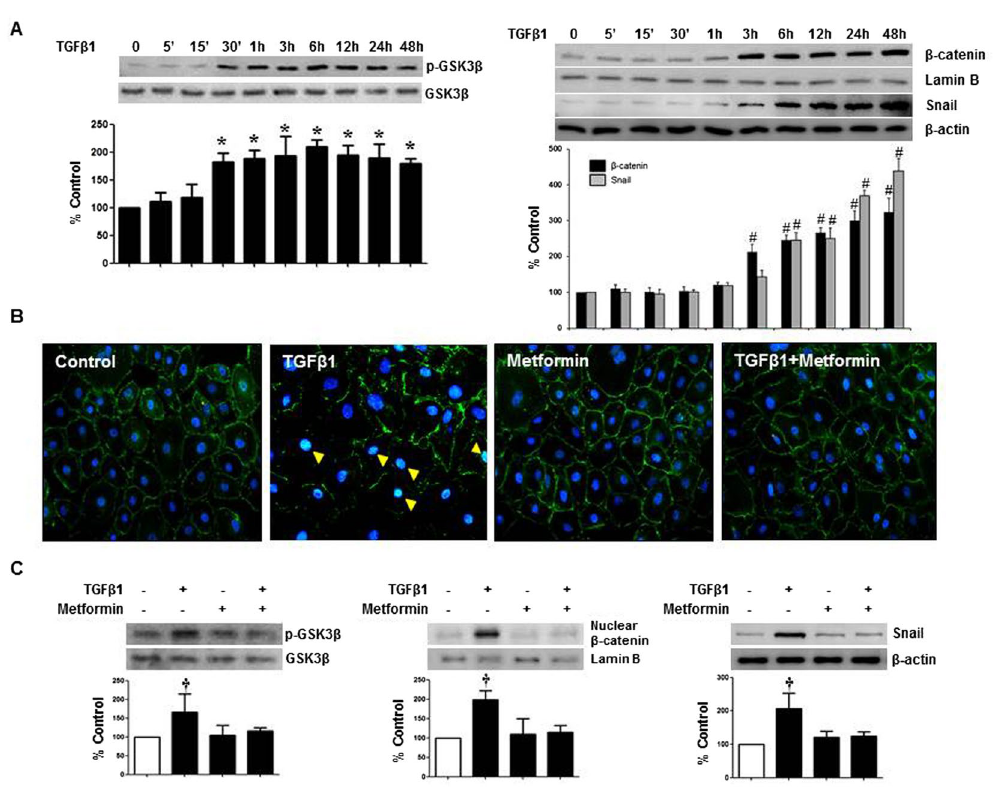
Figure 3. Effect of Metformin on TGF- β -induced Phosphorylation of GSK-3 β , Nuclear Translocalization of β -catenin and Snail Expression. ( A ) TGF- β 1 enhances the phosphorylation of GSK-3 β , nuclear translocation of β -catenin and Snail expression. ( B , C ) Meformin (1 µ M) significantly ameliorates TGF- β -induced activation of GSK-3 β , nuclear translocalization of β -catenin and snail expression ( B , C ). Fluorescein immunocytochemistry of β -catenin (green) and DAPI (blue) reveals the translocation of β -catenin from the cytoplasmic membrane into the nucleus (cyan) upon TGF- β 1 at 12 hours ( B , yellow arrowheads). Representative western blots with quantitative analyses at 12 hours of TGF- β 1 stimulation are shown ( A , C ). (n = 6). * p < 0.05 vs. time points of 0, 5, and 15 minutes, # p < 0.05 vs. time points 0, 5, 15, 30, and 60 minutes, † p < 0.05 vs.